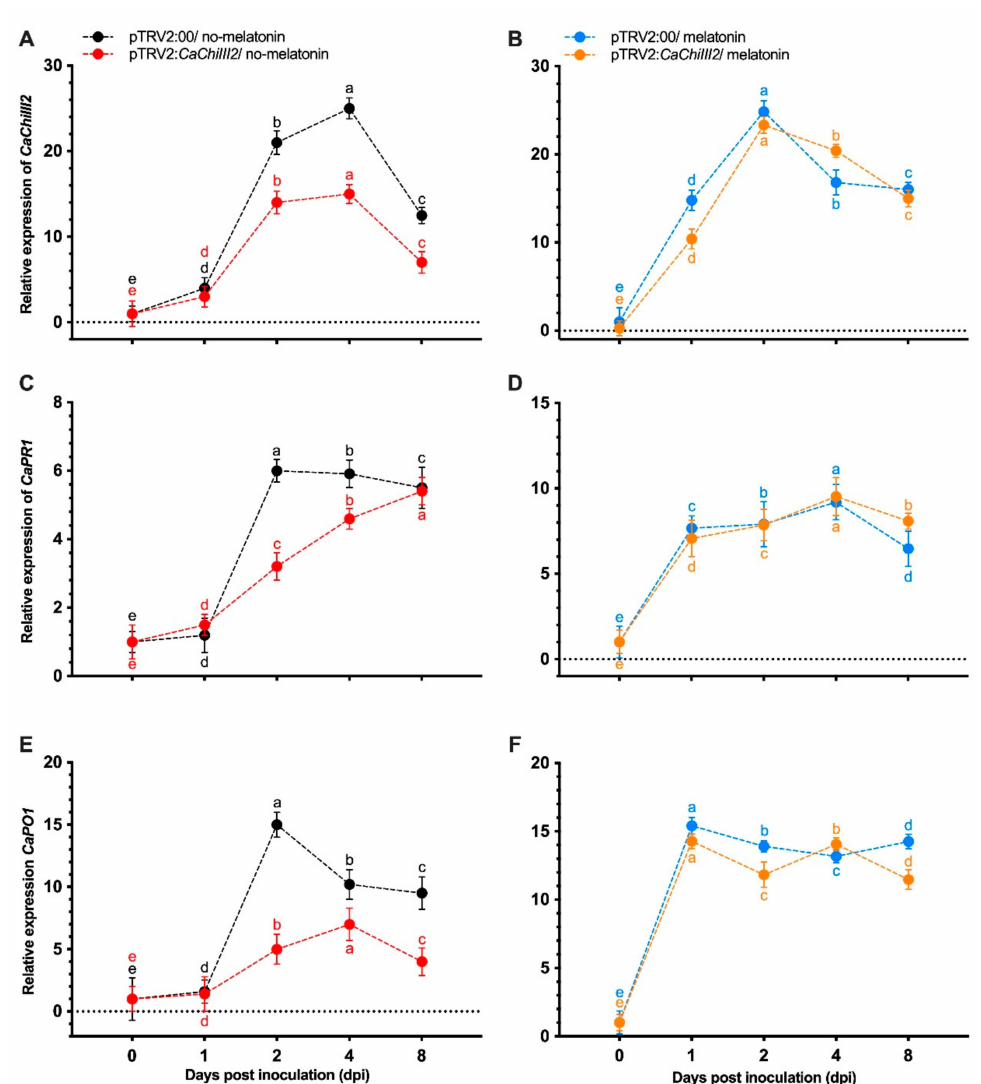
Figure 6. Effect of CaChiIII2 knockdown and exogenous melatonin pretreatment on the defense response of pepper plant against C. gloeosporioides . ( A ) The transcript level of CaChiIII2 without melatonin pretreatment in pTRV2:00 and pTRV2: CaChiIII2, ( B ) 100 µ M melatonin pretreated, ( C ) Transcript level of CaPR1 without melatonin pretreatment